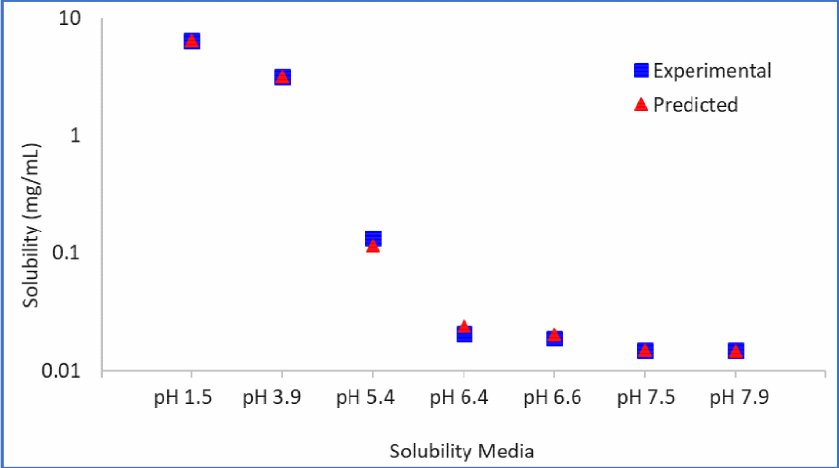
Figure 3. Model drug free form experimental vs. predicted aqueous solubility.